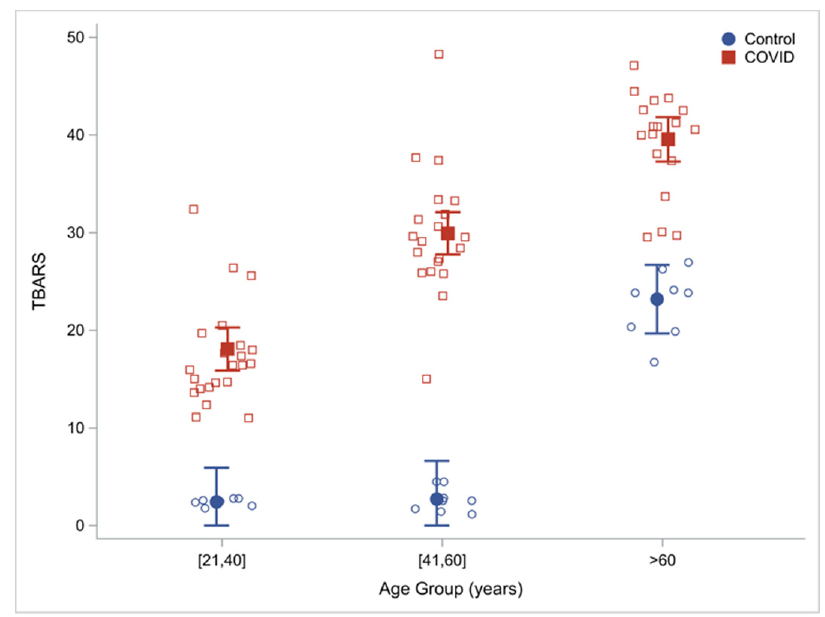
Figure 2. Oxidative stress: plasma TBARS by age group and cohort (COVID-19 patients vs. uninfected controls) with regression estimated means (95% CI) adjusting for cohort, age, group and sex.